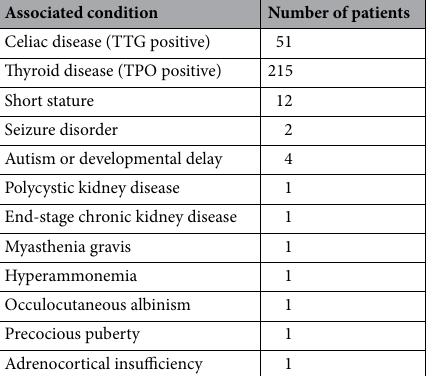
Table 1. Associated condition observed in some patients of the type 1 diabetes mellitus